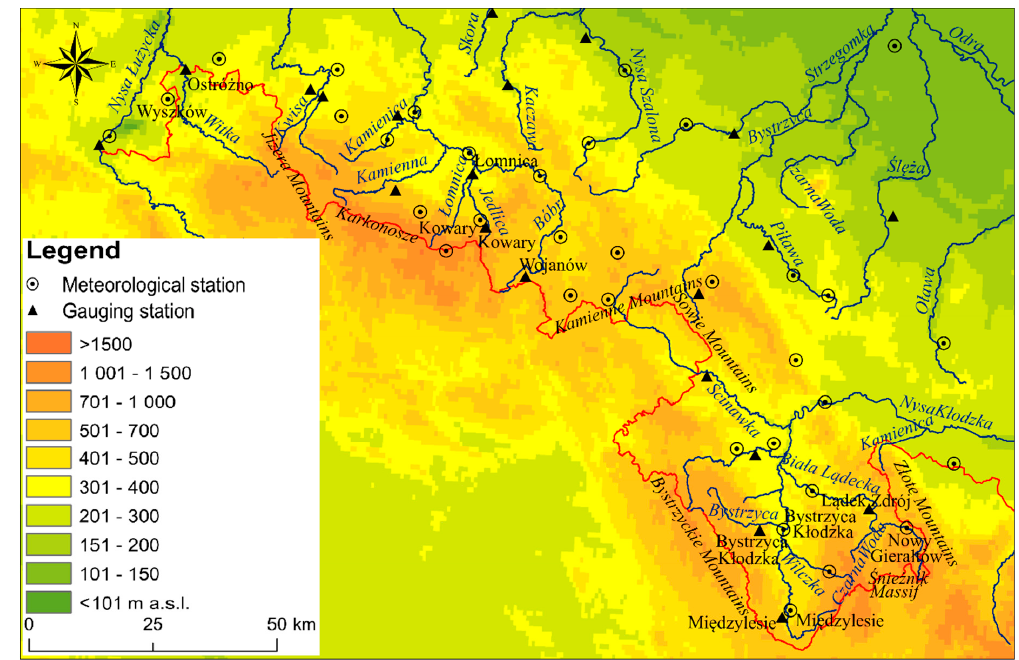
Figure 1. Area of the study with location of 21 gauging stations and 43 meteorological stations used in the study.